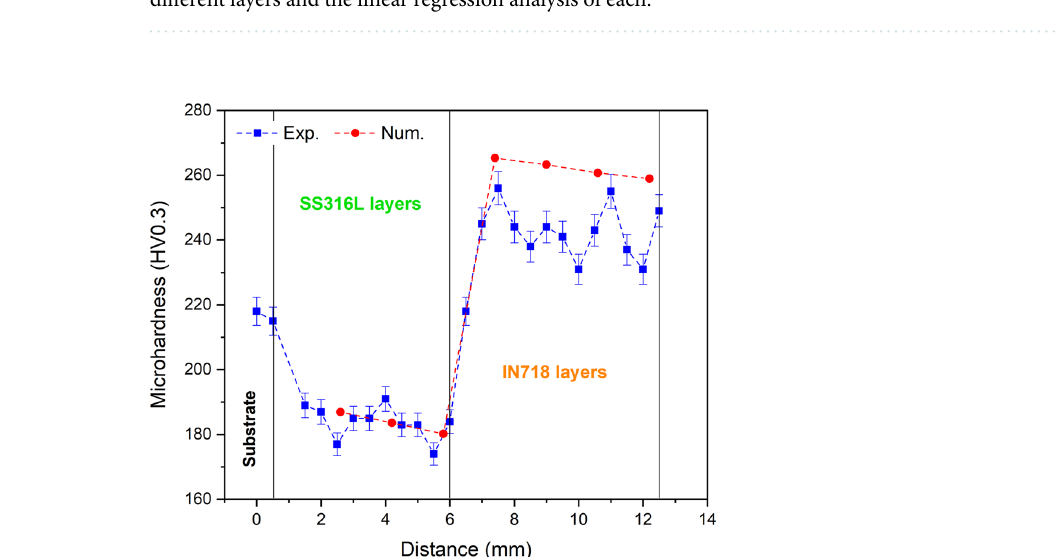
Figure 16. Variations in the fraction of ferrite and Laves phases with the cooling rate (during solidification) in different layers and the linear regression analysis of each.